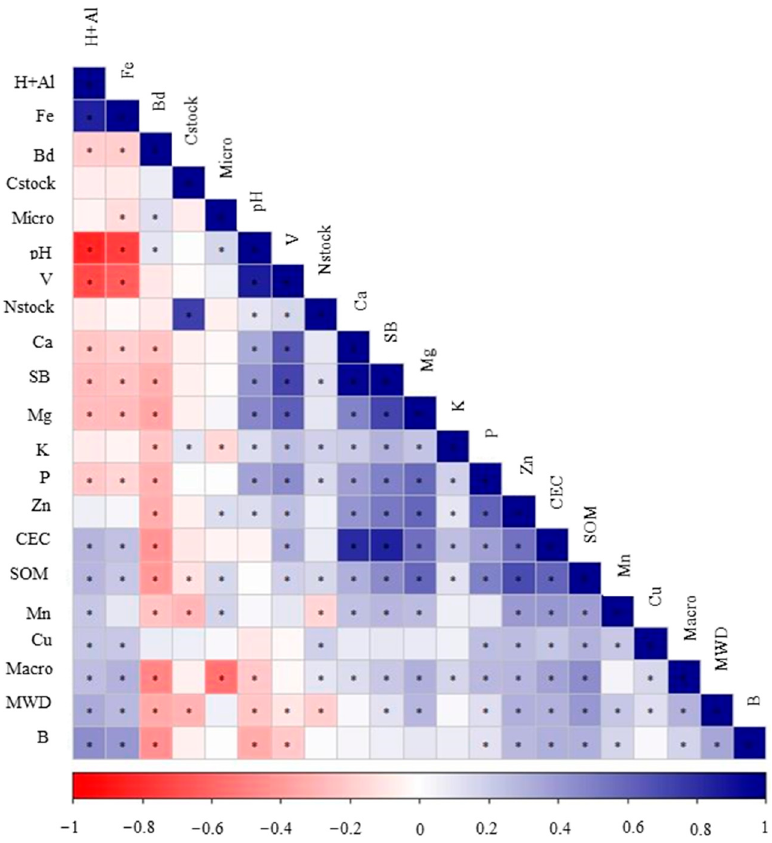
Figure 2. Pearson correlation analysis of physical and chemical attributes of a Quartzipisamment under different use and management systems (foresty, pasture, agroforestry, and silvopastoral). H + Al: hydrogen + aluminum content; Fe: iron content; Bd: bulk density; Cstock: carbon storage; Mi-